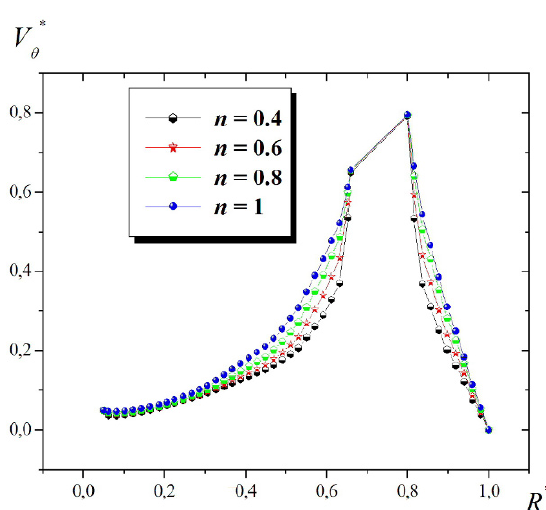
Figure 3. Axial velocity for n = 1.